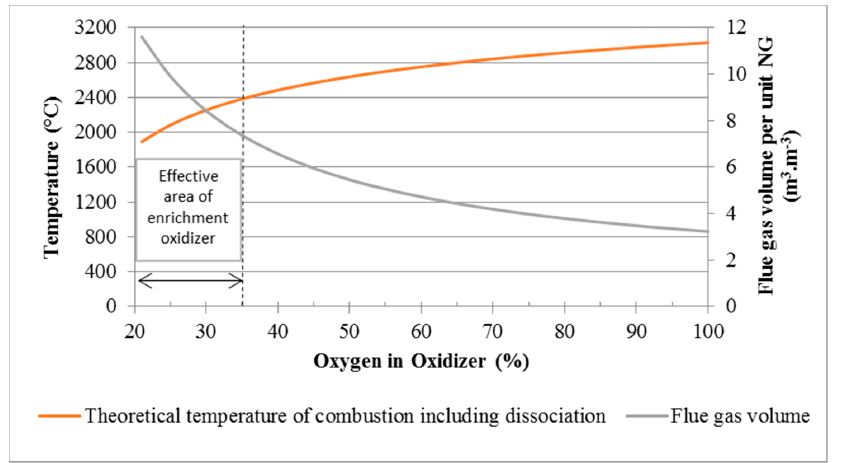
Figure 13. Theoretical combustion temperature including dissociation and flue gas volume per unit of NG (natural gas) as a function the oxygen concentration in the oxidizer (calculated on the basis of the mathematical model).